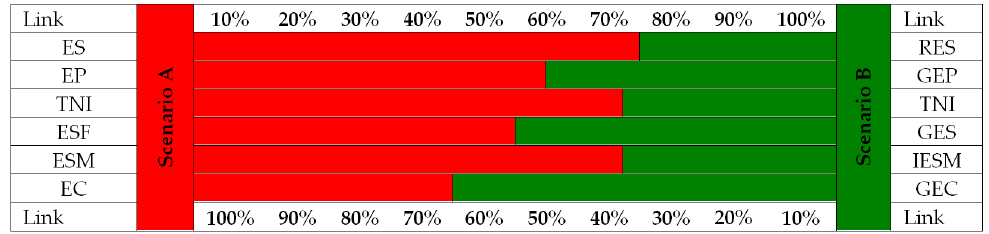
Figure 5. Aggregated expert opinions—indicating only one scenario (second item). Source: own calculation. Red color means the Red Ocean—Scenario A. Green color means the Green Ocean—Scenario B.